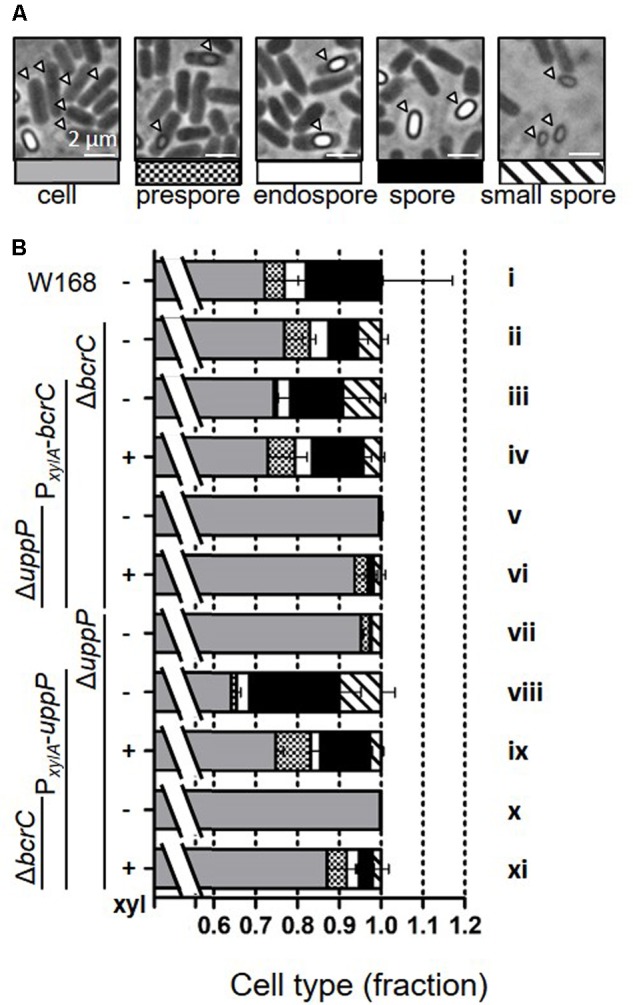
Sporulation efficiencies of bcrC and uppP deletion and complementation mutants. Strains (W168, TMB0297, TMB3694, TMB3739, TMB3408, TMB3695, and TMB3740) were grown as described in Figure 3 and phase contrast microscopy pictures were taken 24 h post-inoculation. (A) Representative pictures for normal cells (gray), prespores without fully established phase-bright endospore (small checkered), completed endospores (white), free spores (black) and small free spores (striped). (B) Cell type fractions are shown as stacked bar graphs. Data is shown for at least 1000 cells per measurement and the error bars represent the standard deviation between independent biological triplicates. The full data set is shown in Supplementary Figure S3.